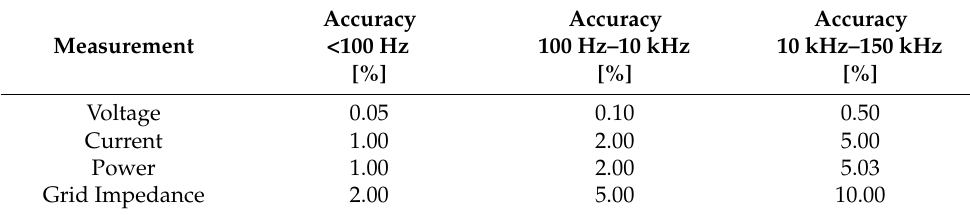
Table 1. Accuracy of measured parameters.